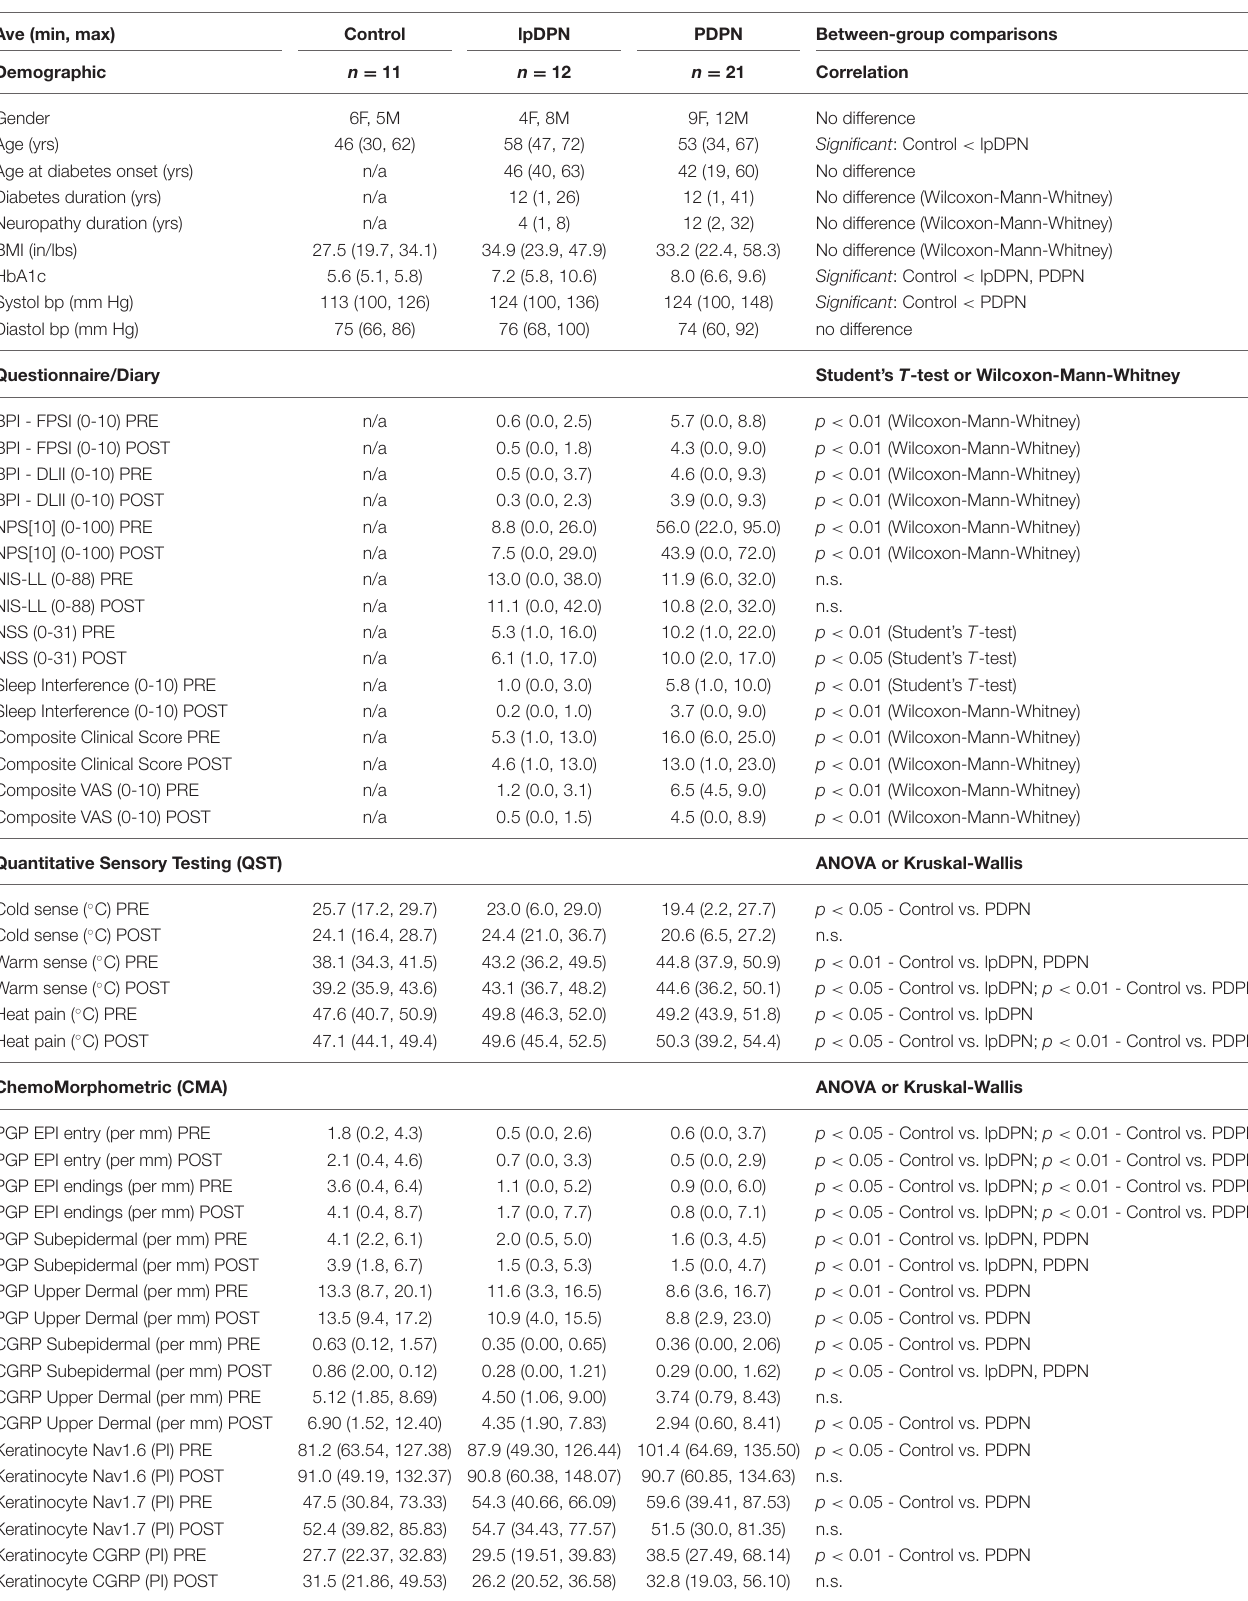
TABLE 1 | Total cohort data